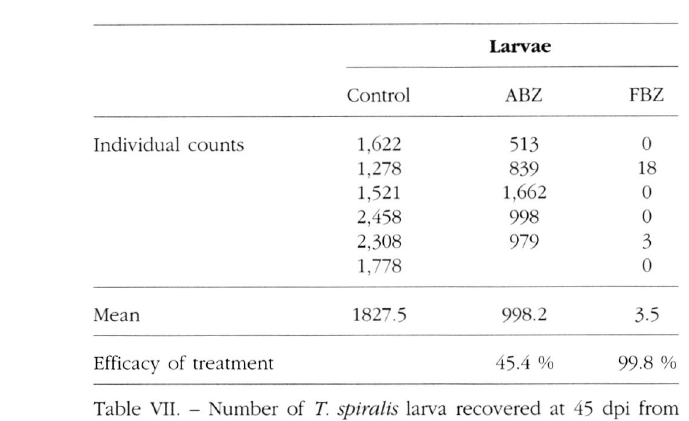
Table VII. - Number of T. spiralis larva recovered at 45 dpi from the diaphragm of mice treated with albendazole and